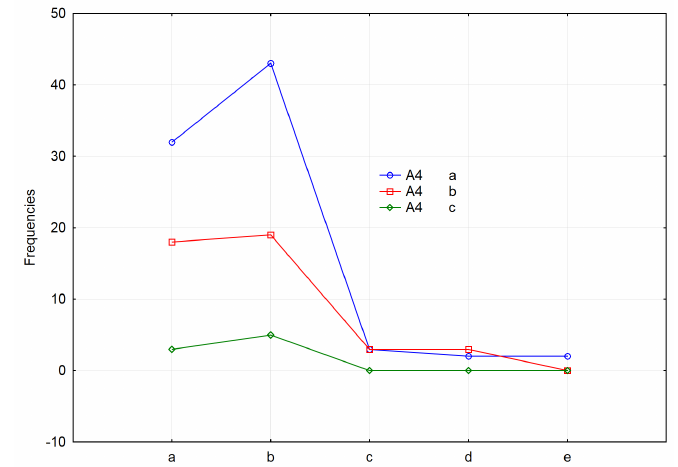
Fig. 1. Frequencies of the particular reasons (a – e) to incorporate digital means in teaching process stated by the group of natural science teachers according to sub-category of